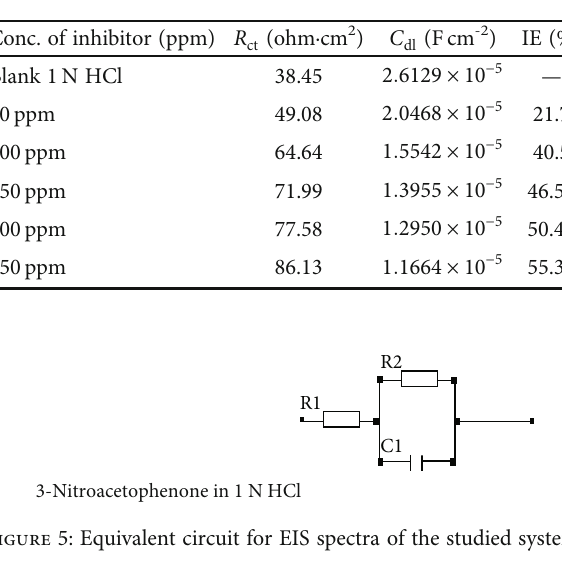
Table 3: The EIS parameter for MS in 1N HCl in the presence and absence of 3-NA.